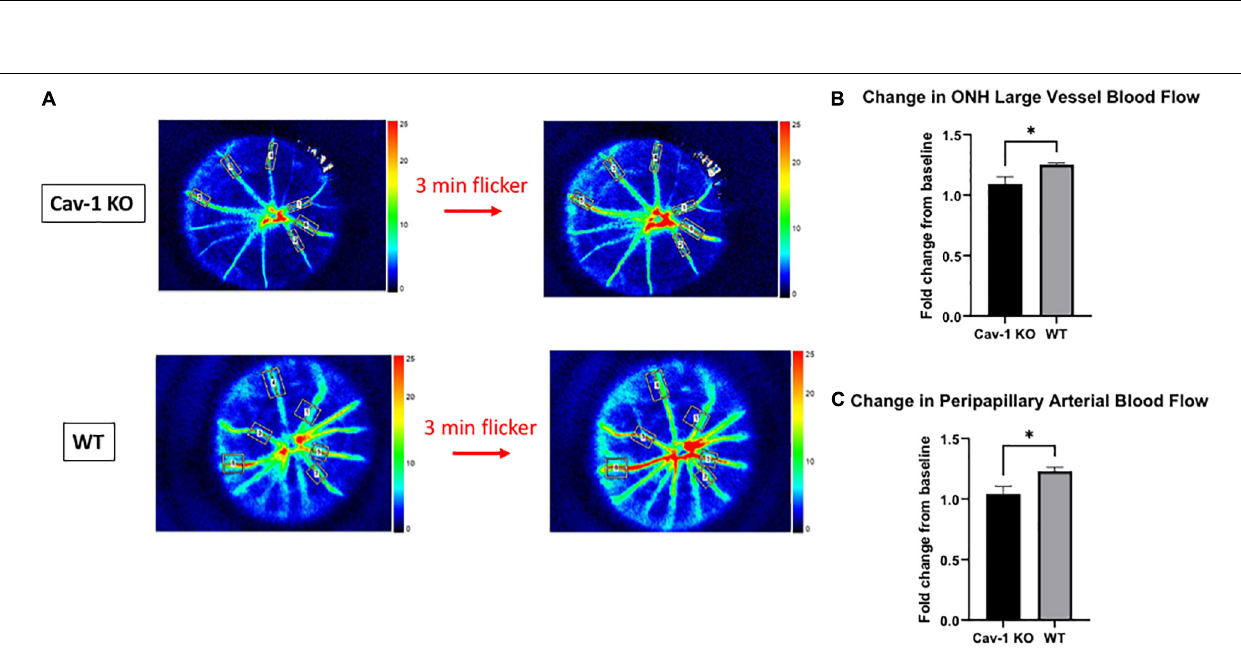
Frontiers in Neuroscience |